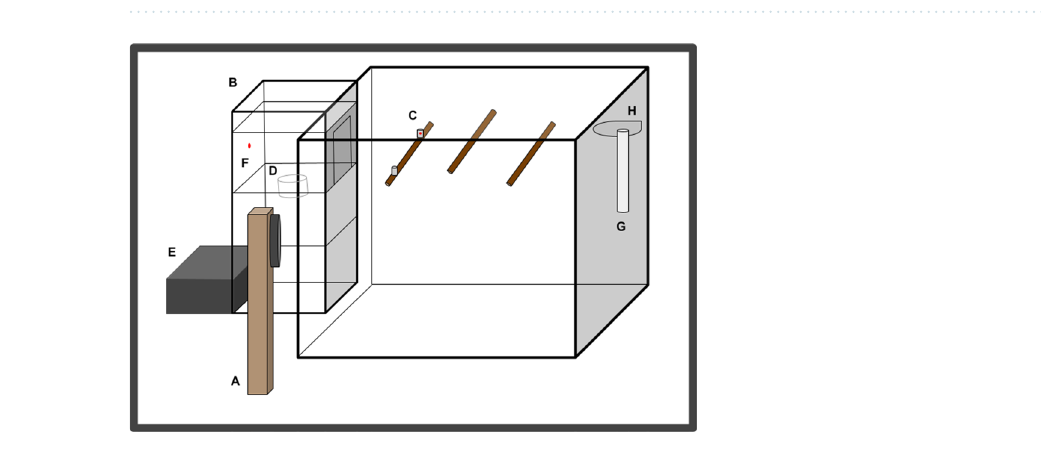
Figure 1. ( A ) Spectrogram of a female fee-bee song in silence. ( B ) Power spectrum of female fee-bee song in silence . ( C ) Spectrogram of female fee-bee song in low noise. ( D ) Power spectrum of female fee-bee song (black) in low noise (grey). ( E ) Spectrogram of female fee-bee song in high noise. (F) Power spectrum of female fee-bee song (black) in high noise (grey).